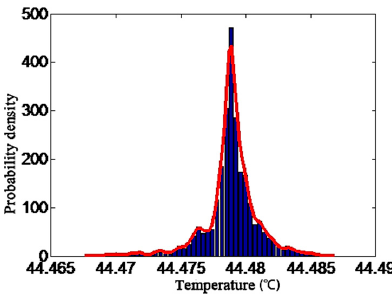
Figure 4. Thermal probability density (TPD) under normal conditions.